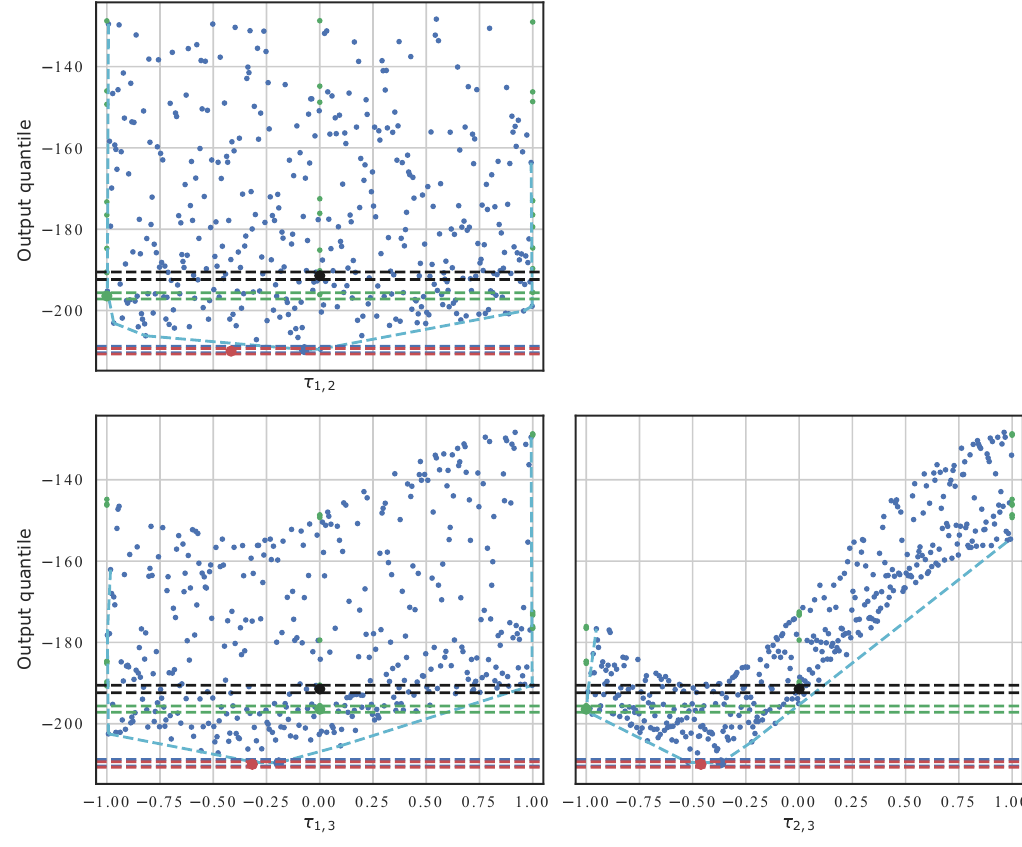
Figure 4: Matrix plot of the output median in function of the Kendall coefficient of each pair. The blue dots represents the esti- mated quantiles of Method 1. The black point is the quantile at independence and the minimum of Method 1 and 2 are the red and blue points, which are equivalent here. The green point is the the minimum with only Fréchet-Hoeffding bounds. The 95 % bootstrap confidence interval are displayed in dot lines.